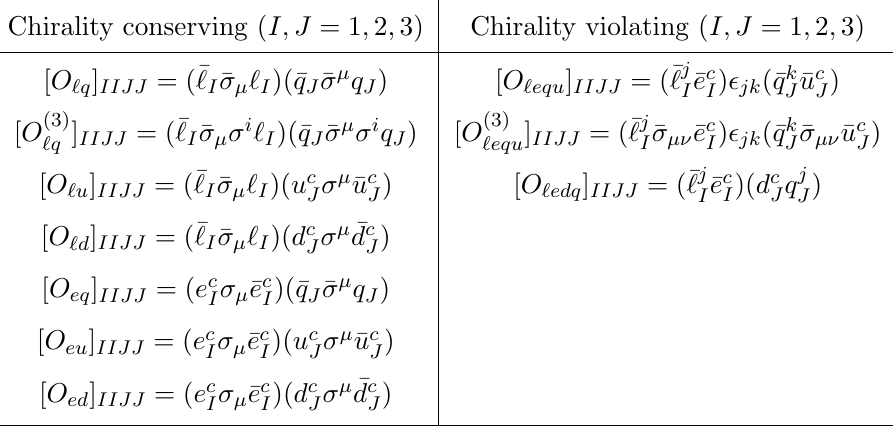
Table 1 . Flavor-conserving 2-lepton-2-quark operators in the SMEFT Lagrangian of eq. (2.1). One (cid:13)avor ( I = 1 ; 2 ; 3)